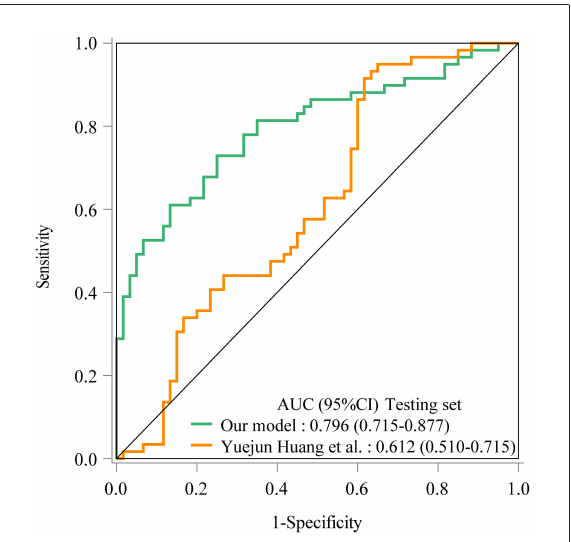
FIGURE2 The ROC curve showed the predictive ability of the prediction model in the testing set in our model and Yuejun Huang et al.’s